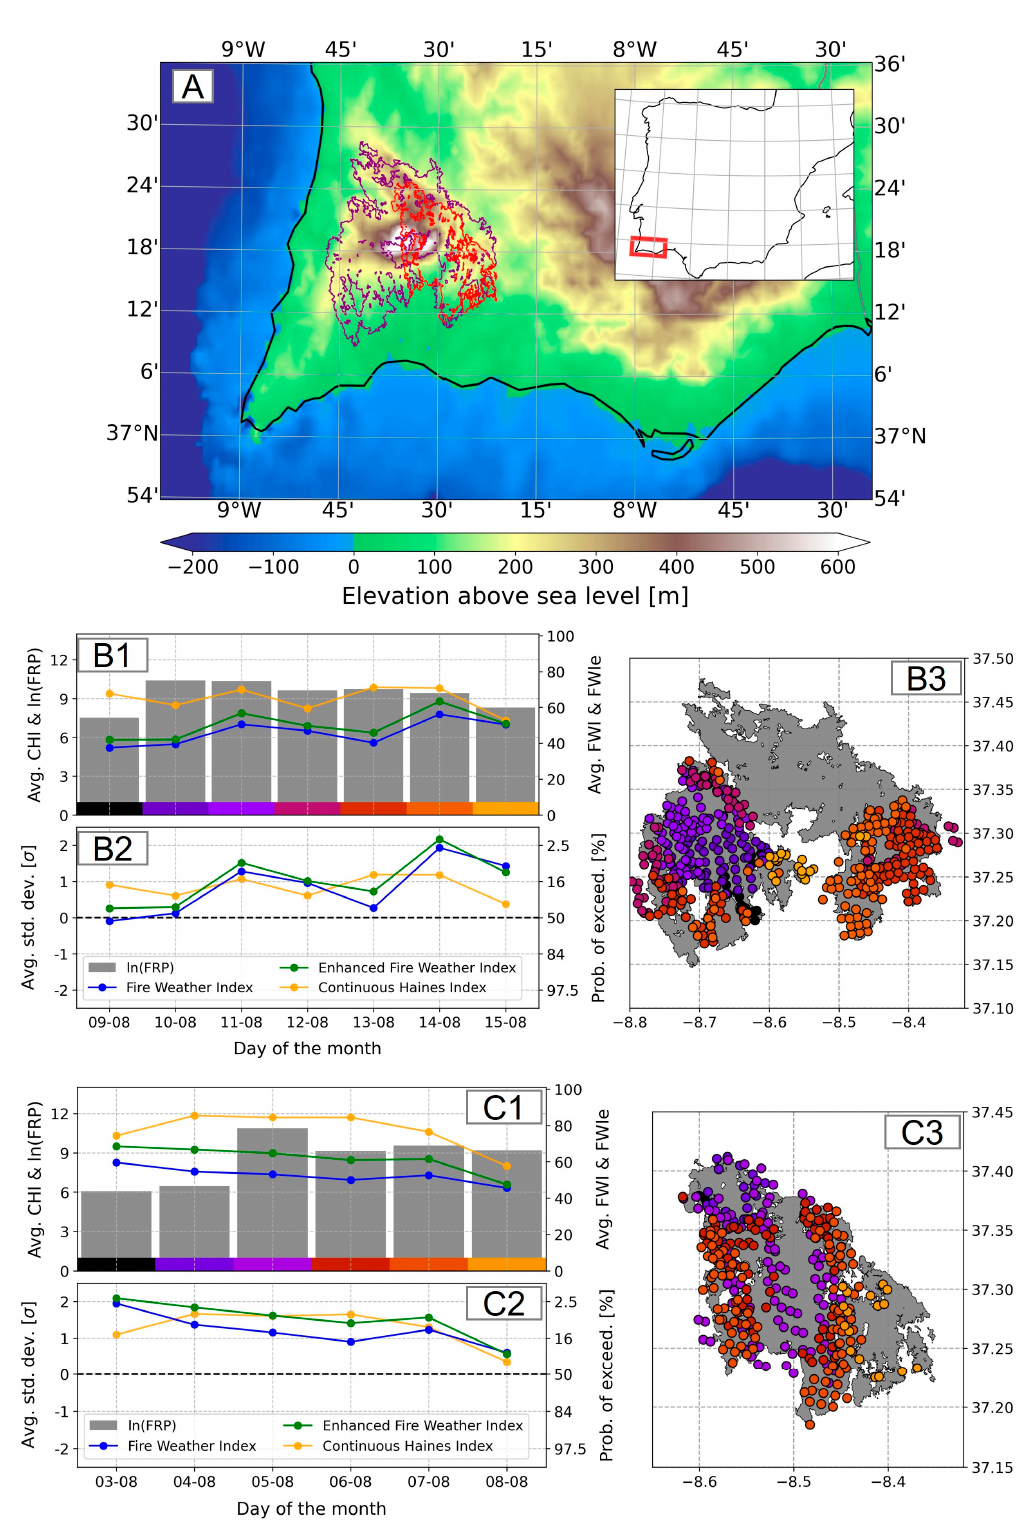
Figure 8. Study case for the Monchique region. Panel ( A ) shows the analyzed area, with the shapes representing the burned areas for 2003 (purple) and 2018 (red); topography is shown by colors. Panels ( B1 – B3 ) and ( C1 – C3 ) show the respective episodes for 2003 and 2018. Subplots 1 and 2 in these panels are as shown in Figure 6, with the addition of the colors corresponding to the day in subplot 3, depicting the affected region and the FRP location via the scattered colored